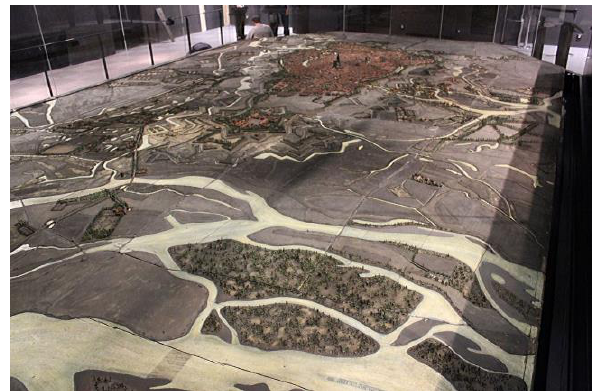
Figure 1. The plan-relief of Strasbourg (12 m x 6 m) is protected in a glass showcase that is difficult to access and in lighting conditions that are not suitable for